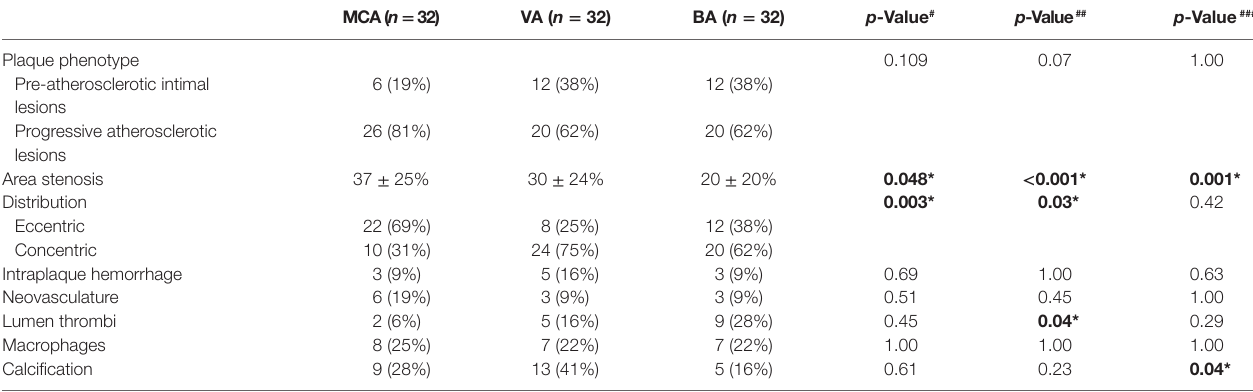
TaBle 2 | Comparisons of plaque characteristics among middle cerebral artery (MCA), vertebral artery (VA), and basilar artery (BA) groups.